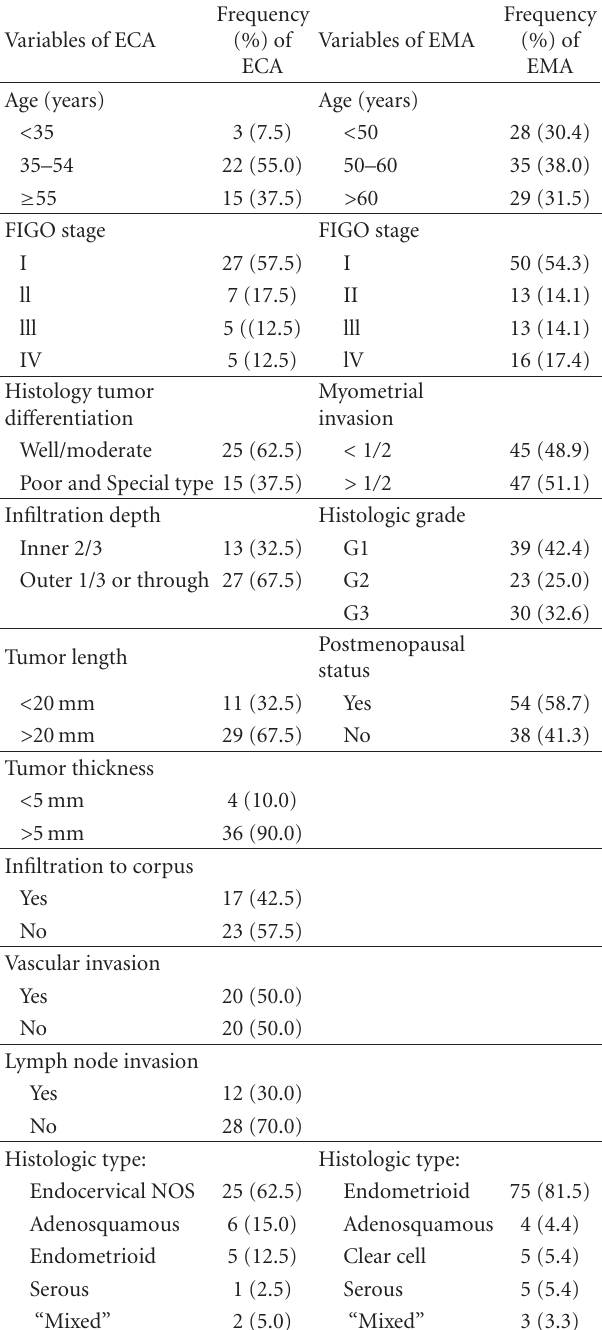
Table 1: Summary of the clinicopathological parameters in adeno- carcinoma of the cervix (ECA) and adenocarcinoma of the endo- metrium